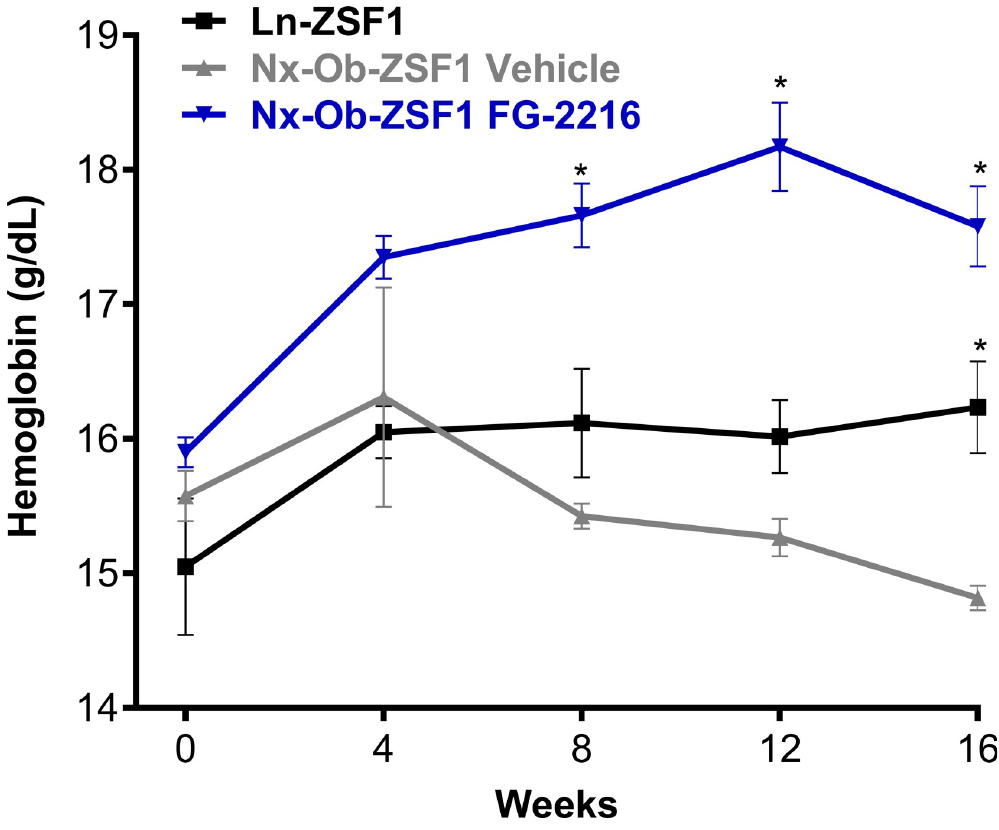
Fig 2. FG-2216 corrected hemoglobin levels in Nx-Ob-ZSF1 rats. Hemoglobin levels were determined from blood collected every four weeks during treatment. Values represent mean ± SEM (n = 6–12). � P < 0.05 vs . Nx-Ob-ZSF1 Vehicle (Bonferroni